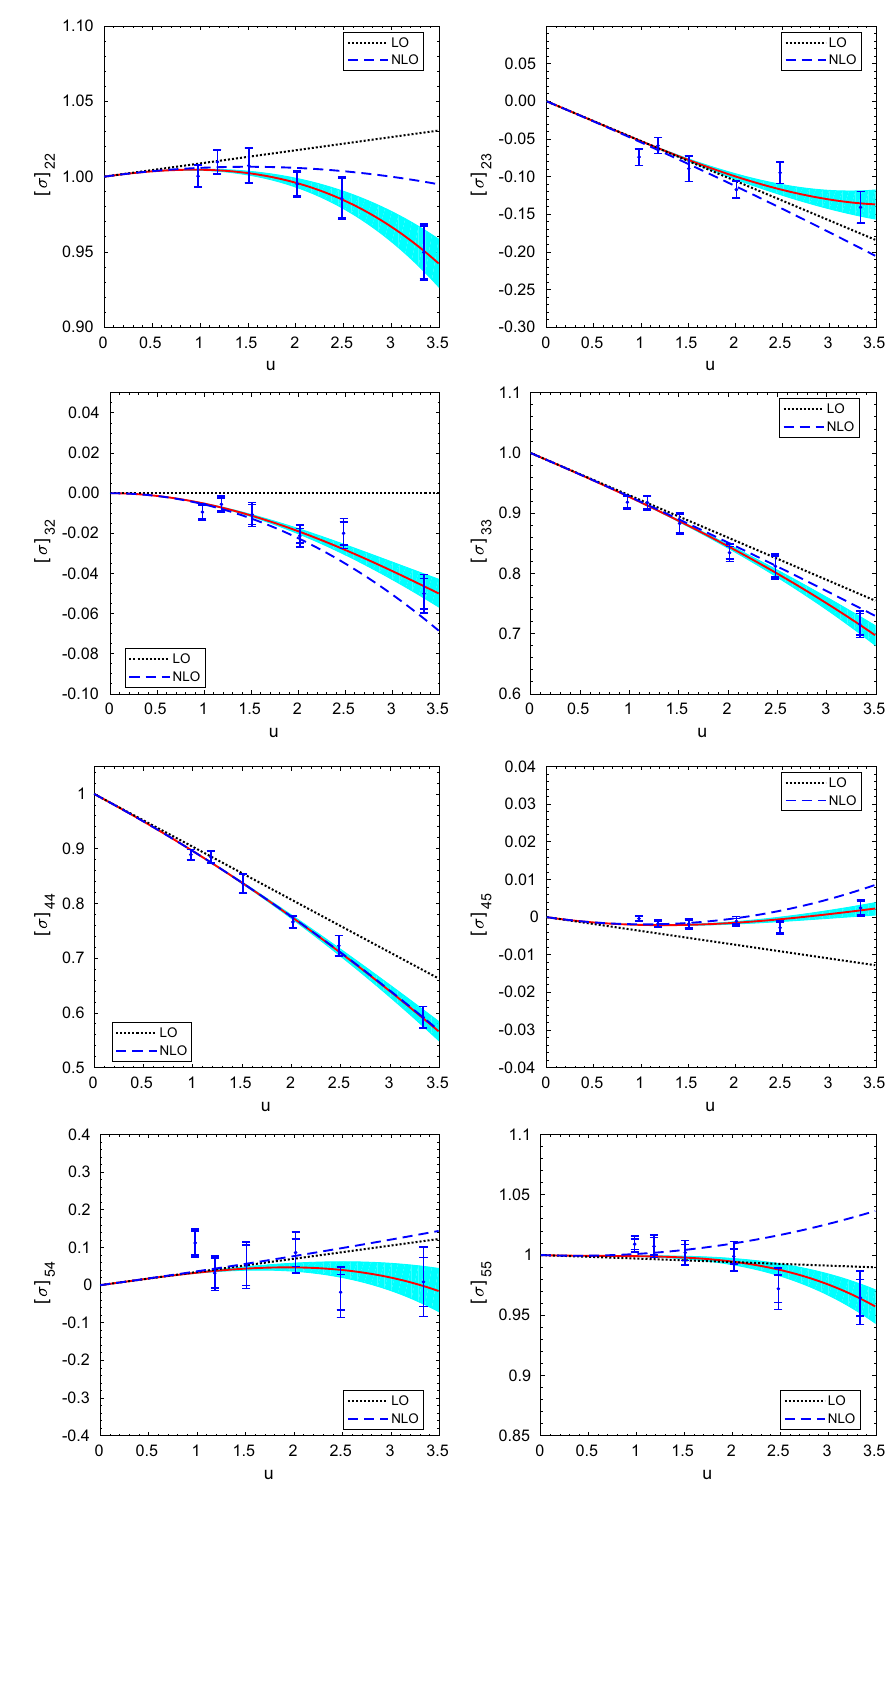
Fig. 7 Continuum matrix-SSFs , Q − } for operator bases { Q − 2 3 , Q − } (bottom). (top) and { Q − 4 5 The LO perturbative result is shown by the dotted black line, while the NLO one by the dashed blue line. The red line (with error band) is the non-perturbative result from the O ( u 3 ) fit as described in the text. The two error bars on each data point are the statistical and total uncertainties; the systematic error contributing to the latter has been estimated as explained in the